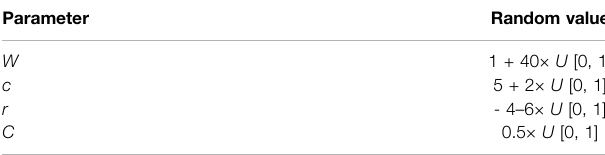
TABLE 1 | Random generation rule of hyper-parameters of the biased cost function in CIPE.